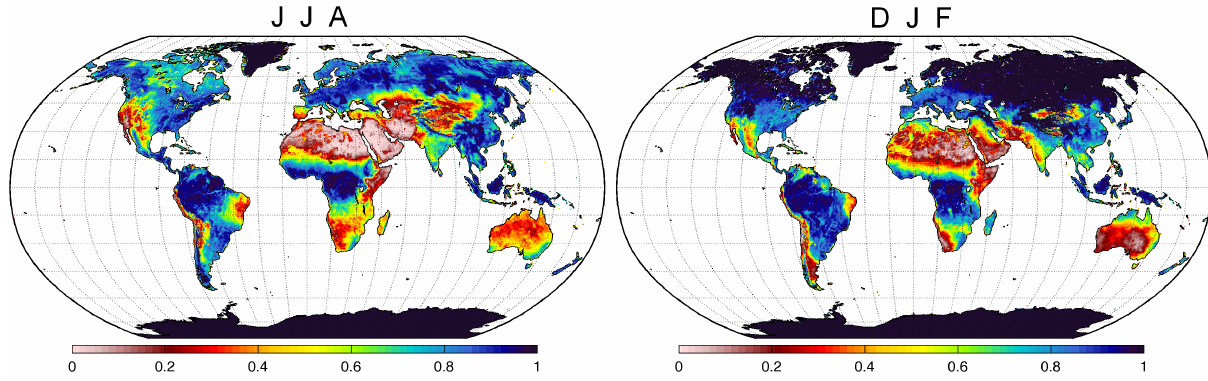
Fig. 9. Estimated stress factor ( S ) as averaged for the months of JJA and